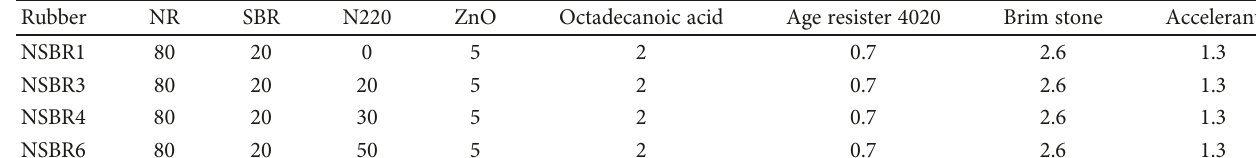
Table 1: Ingredients of carbon black- fi lled NSBR composites.